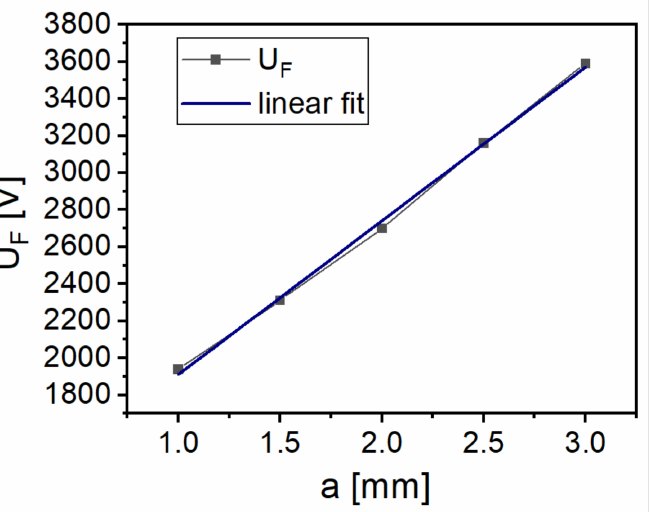
Figure 13. Best focus voltage as a function of Einzel lens size for sharp silicon/CNT